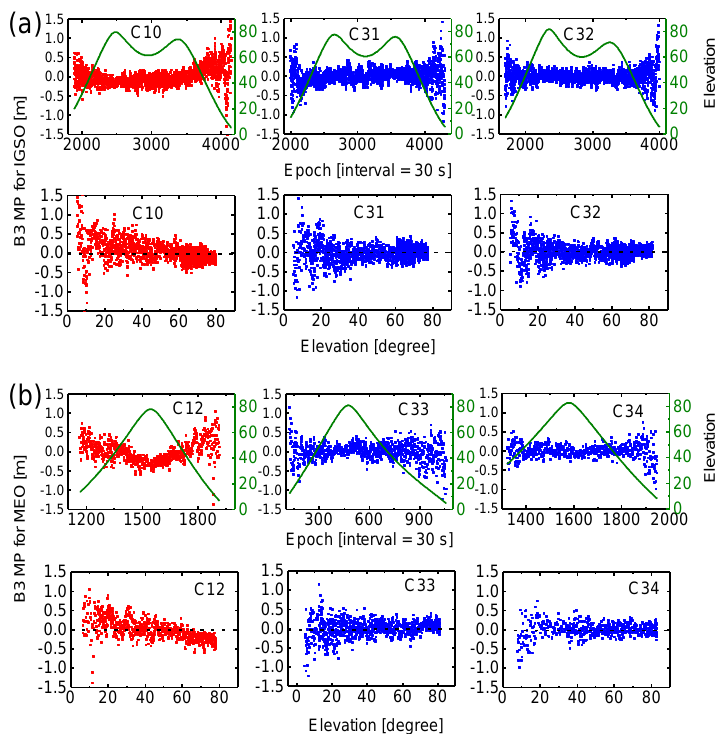
Figure 5. MP combinations of BDS-2 (red) and BDS-3 (blue) B3 frequency as a function of time and a function of elevation angle for ( a ) IGSO, and ( b ) MEO satellites at station BJF1.